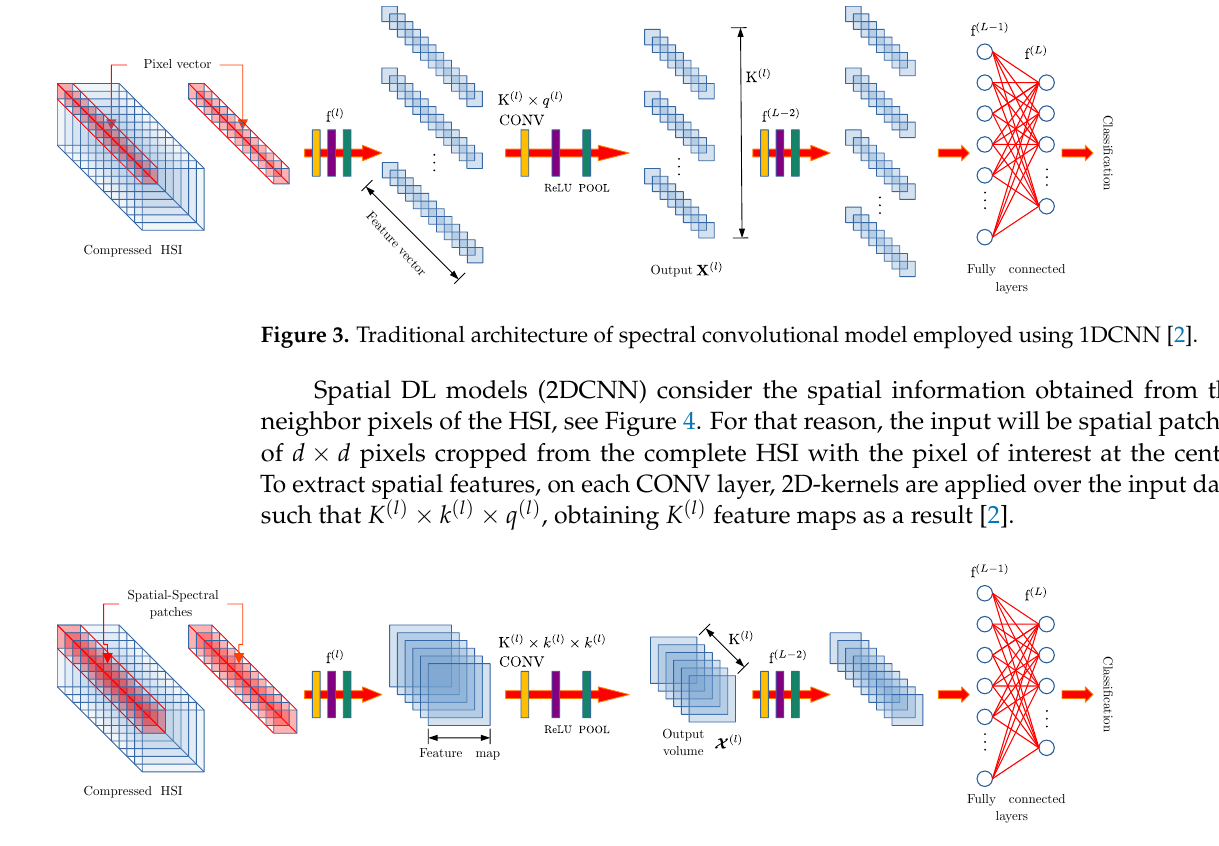
Figure 4. Traditional architecture of spatial convolutional model employed using 2DCNN [2]. Spectral–spatial DL models (3DCNN) extract spectral and spatial features at the same time, see Figure 5. Similarly, as with 2DCNN, the features are extracted from spatial patches of d × d , associated with a single pixel of the HSI. This model uses 3D-kernels, such that K ( l ) × k ( l ) × k ( l ) × q ( l ) , extracting K ( l ) feature volumes as output [2].